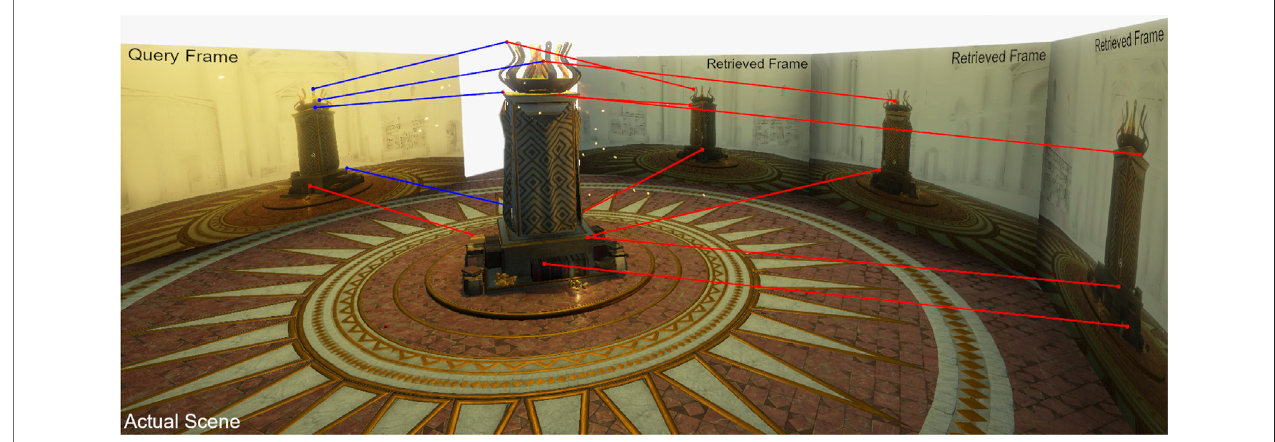
FIGURE1| Visualizationofourgazemapping:Fora QueryFrame ,similarframesareretrievedfromthedatabase( RetrievedFrames ),andcapturedgazepoints(red dots) from other users are projected to the current frame (blue lines).